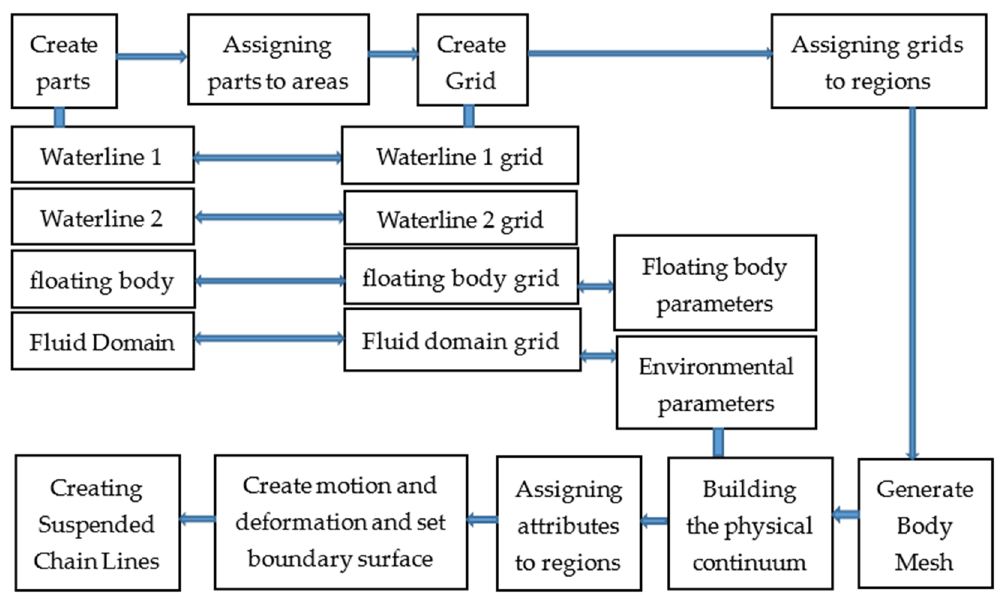
Figure 3. Numerical simulation flow chart.